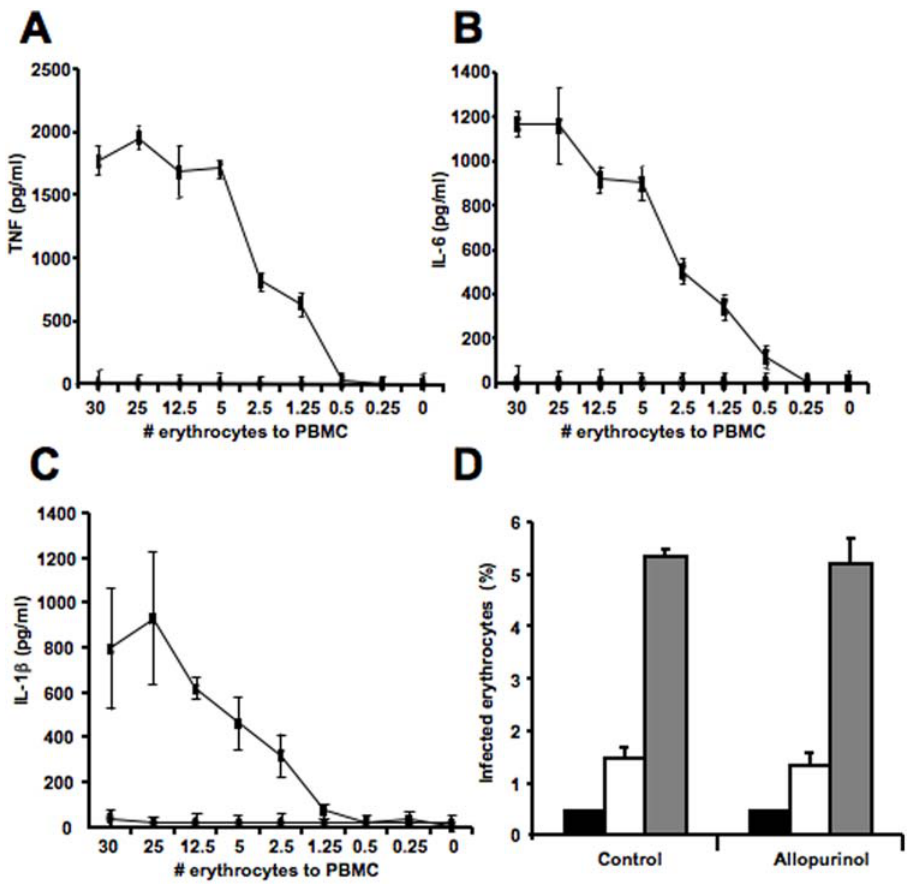
Figure 2. Mature P.falciparum infected erythrocytes induce TNF, IL-6 and IL-1 b from PBMCs. (A–C) PBMCs were incubated with mature P. falciparum infected erythrocytes (squares) or uninfected erythrocytes (circles) at the indicated ratio of erythrocyte to PBMC for 6 h. Data represent the average of triplicated samples with standard deviations. Incubation media were collected and TNF (A), IL-6 (B), or IL-1 b (C) concentrations were determined by flow cytometry using cytometric bead array. (D) P. falciparum infected erythrocytes were cultivated alone or in the presence of 2 mM allopurinol. Synchronized cultures were seeded at 0.5% rings and the culture media was changed daily. The percentage of infected erythrocytes was calculated after 0 h (black bars), 24 h (white bars) and 48 h (grey bars) of